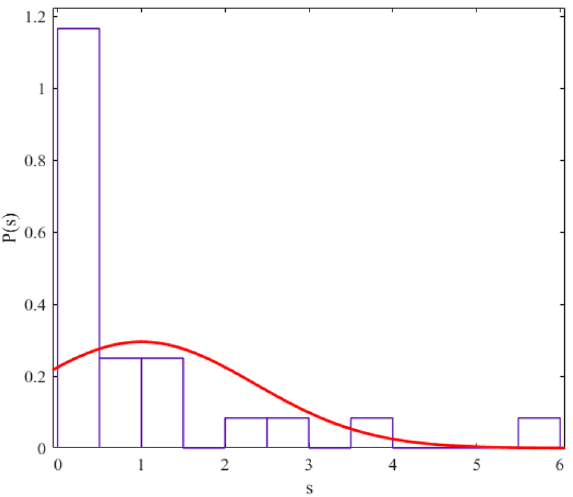
Figure 2. The statistical distribution of 2 + g energy level. The histogram presents the unfolded energy levels and the curve describes the Berry-Robnik distribution, Eq. (12).